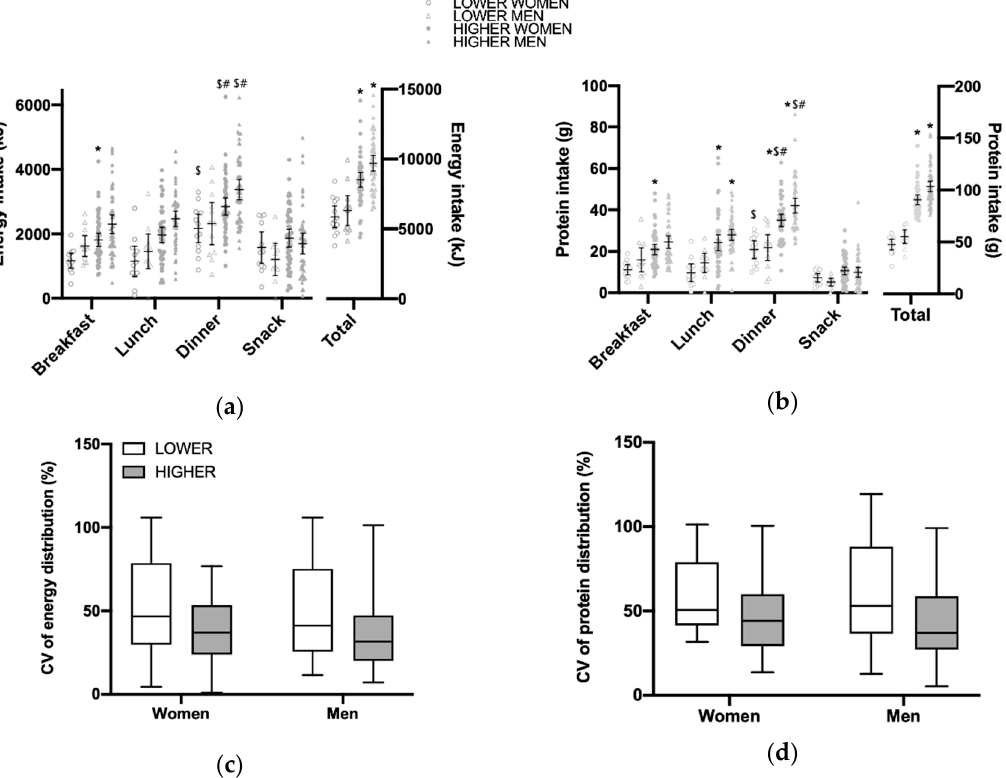
Figure 1. Baseline average energy ( a ) and protein ( b ) intake and distribution per meal, snacks during